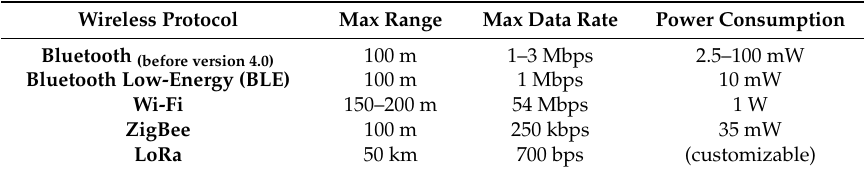
Table 2. Wireless Protocols main features